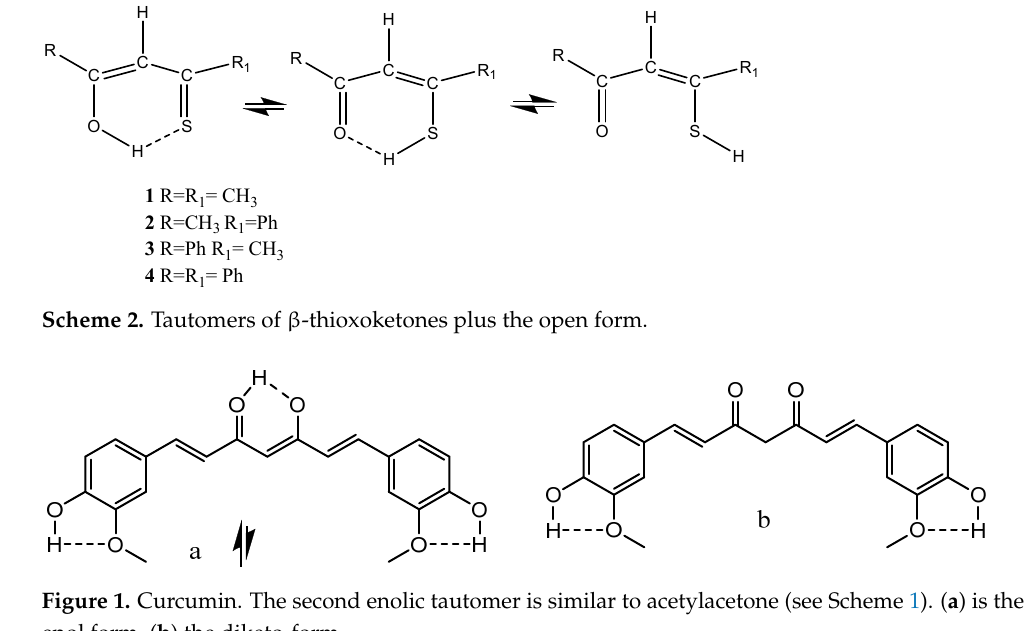
2 Figure 1. Curcumin. The second enolic tautomer is similar to acetylacetone (see Scheme 1). ( a ) is the enol form, ( b ) the diketo-form. 1.2. β -Thioxoketones β -Thioxoketones (see Scheme 2) and β -diketones are in many ways complementary. Both types display strong intramolecular hydrogen bonds, show tautomerism, and have